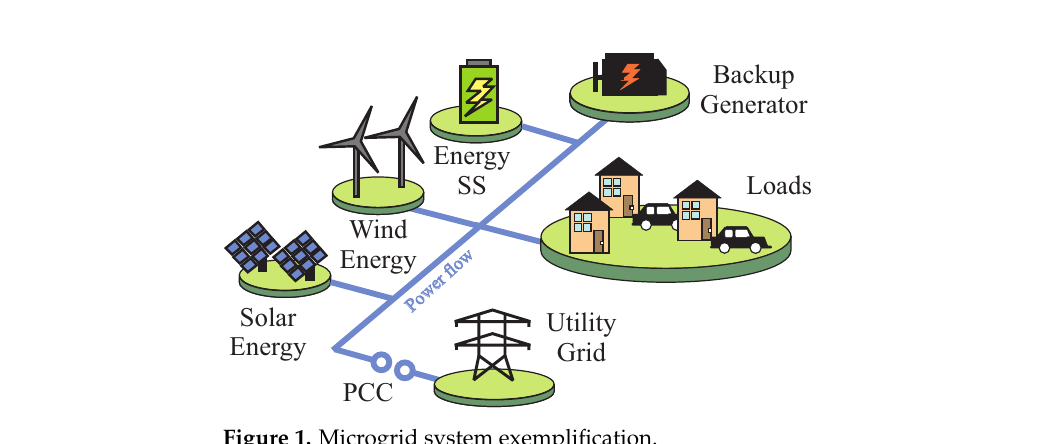
Figure 1. Microgrid system